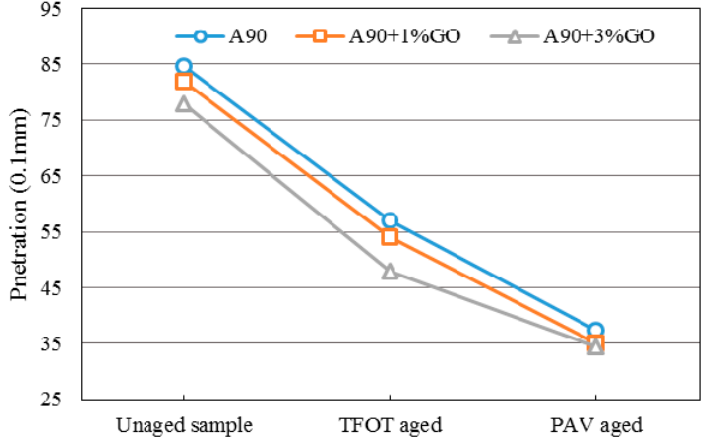
Figure 6. Penetration of GO-modified 70A and its matrix before and after aging.